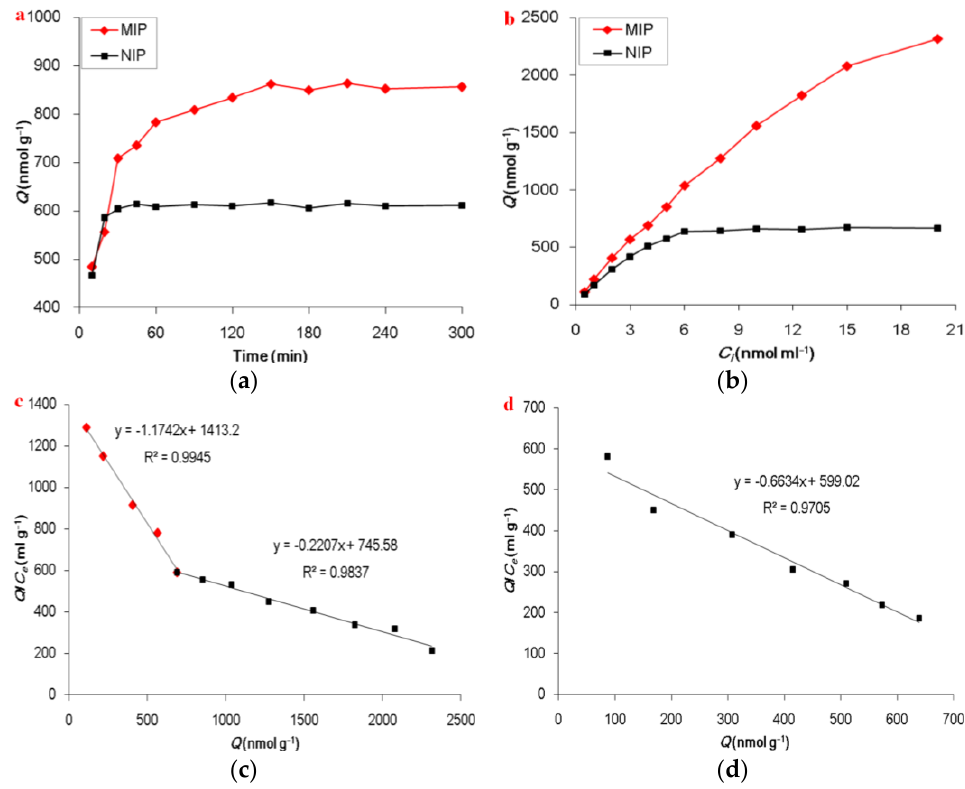
Figure 3. Kinetic adsorption curves of OS on OSMIP@silica gel and NIP@silica gel ( a ), static adsorption of OS on OSMIP@silica gel and NIP@silica gel ( b ), Scatchard plot for OS on OSMIP@silica gel ( c ) and NIP@silica gel ( d ).